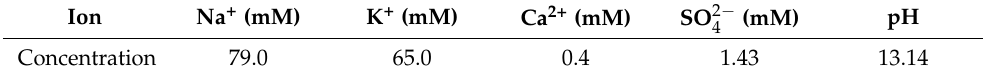
Table 1. Initial concentrations of the free ions and the pH value in the pore solution of the model. Ion Na + (mM) K + (mM) pH Concentration